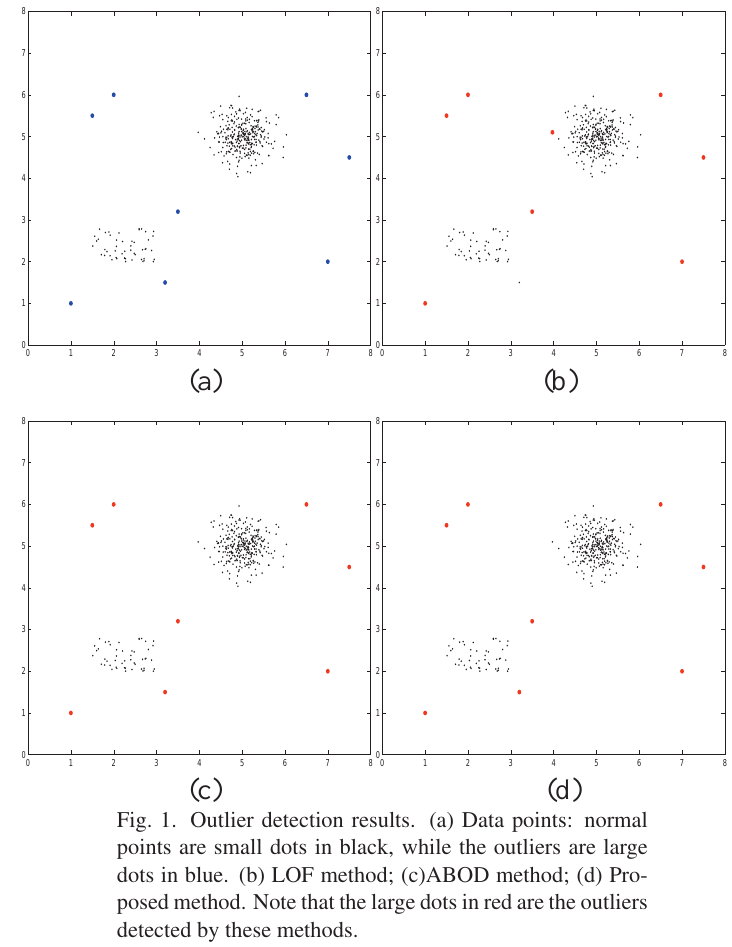
Fig. 1. Outlier detection results. (a) Data points: normal points are small dots in black, while the outliers are large dots in blue. (b) LOF method; (c)ABOD method; (d) Pro- posed method. Note that the large dots in red are the outliers detected by these